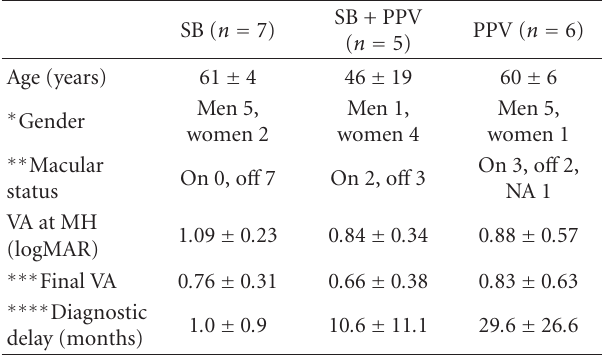
Table 2: Di ff erences among the types of RD surgeries: SB, PPV + SB, and